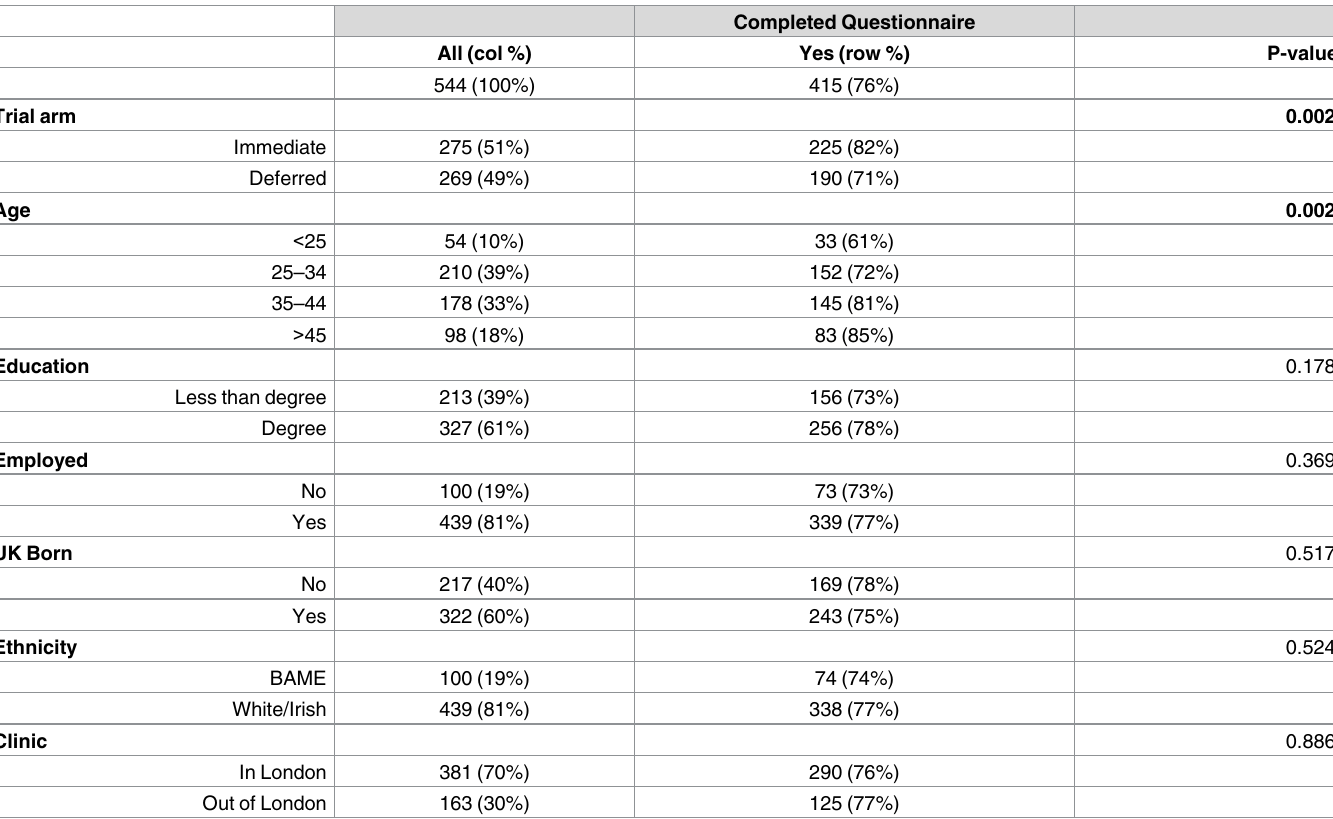
Table 1. Comparison of participants who complete an acceptability questionnaire to those who